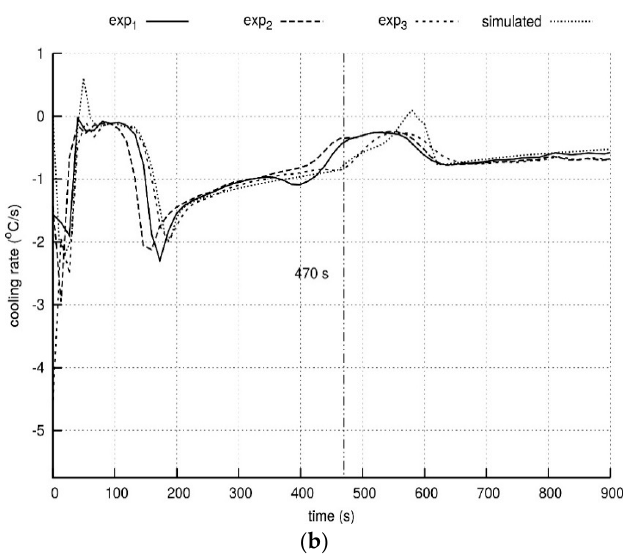
Figure 6. Comparison of experimental and simulated ( a ) cooling curves and ( b ) cooling rate curves, at the center of the specimen (zone 5). The solidification and eutectoid transformation zones are enlarged.